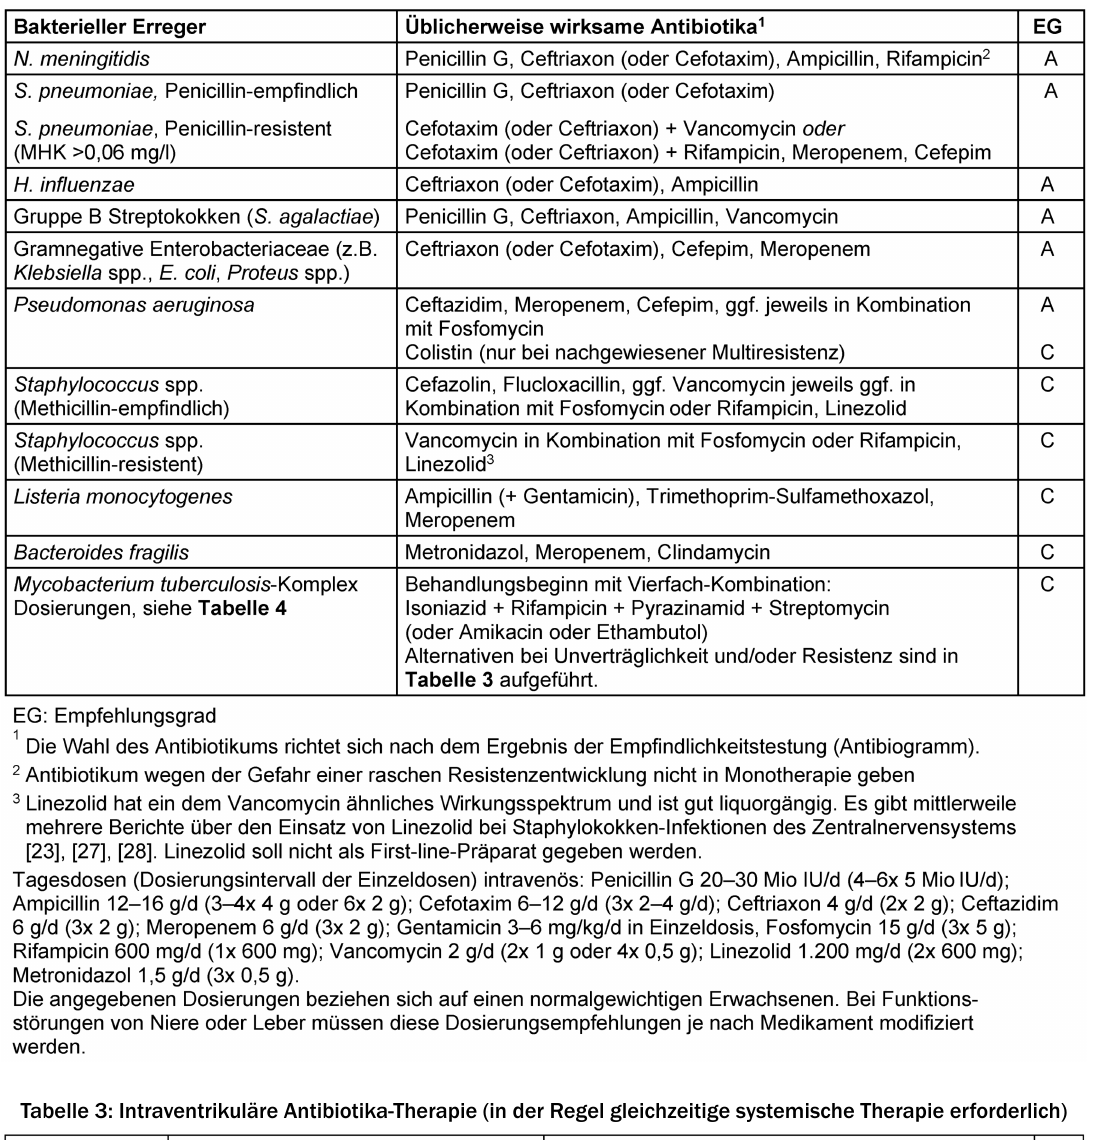
Tabelle 2: Gezielte Antibiotika-Therapie der bakteriellen Meningitis bei Erwachsenen [nach Leitlinien der Deutschen